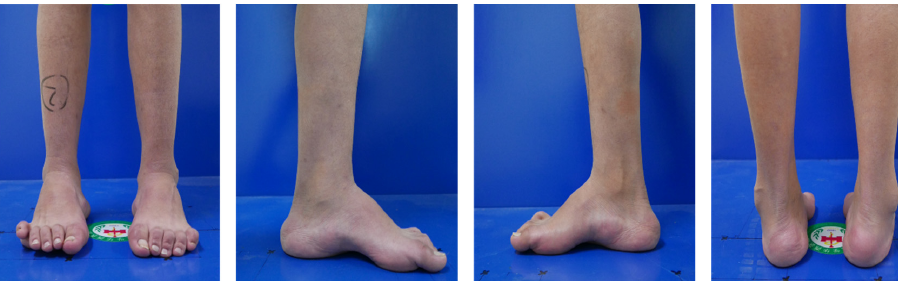
Figure 3. The outlook of bilateral cavovarus foot.